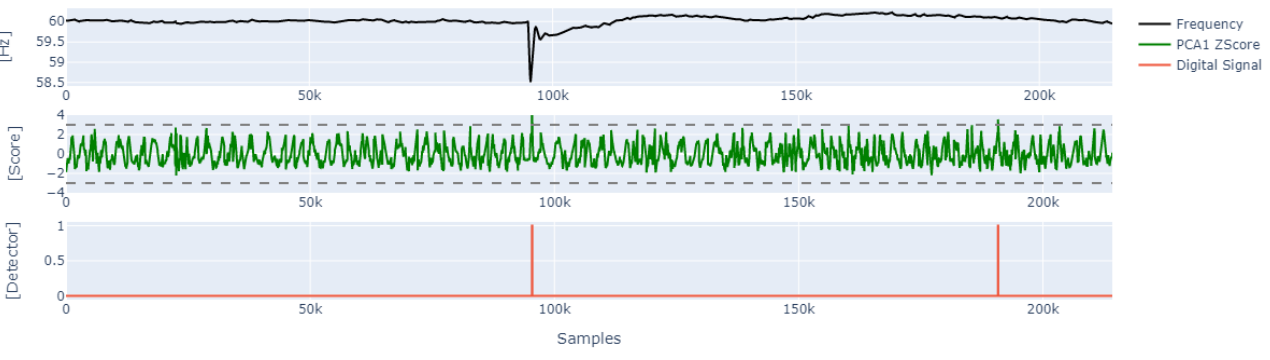
Figure 7. Event 1: frequency of PMU Bateias (in the east of Parana State).